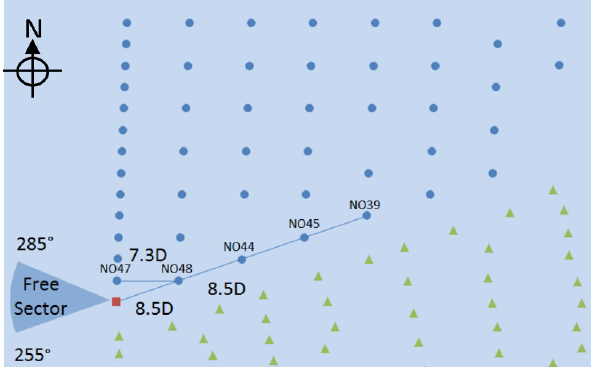
Figure 6. Nordsee Ost (blue cycles) with neighbouring wind farm Meerwind Süd (green triangles) and meteorological mast (red square) (Mittelmeier et al.,